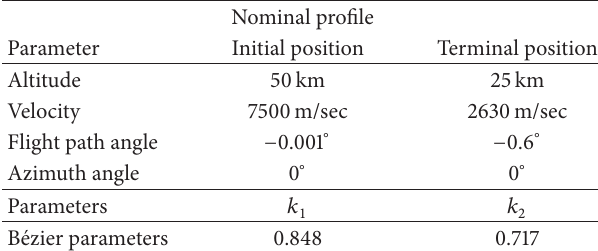
Table 3: Monte Carlo simulation